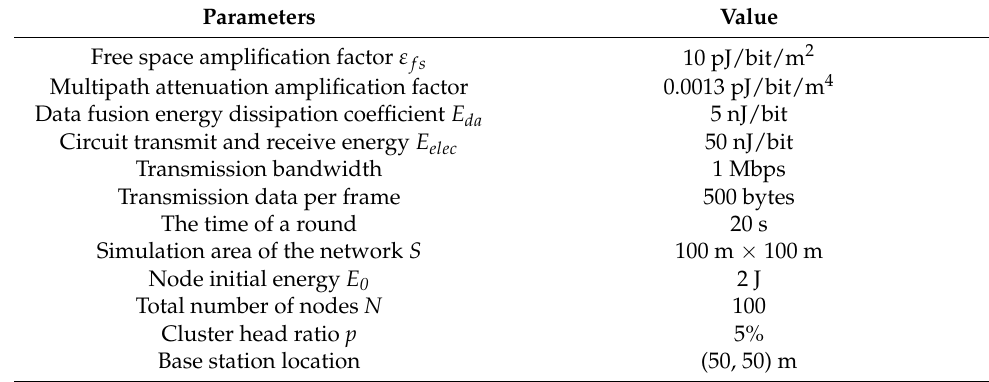
Table 1. Simulation